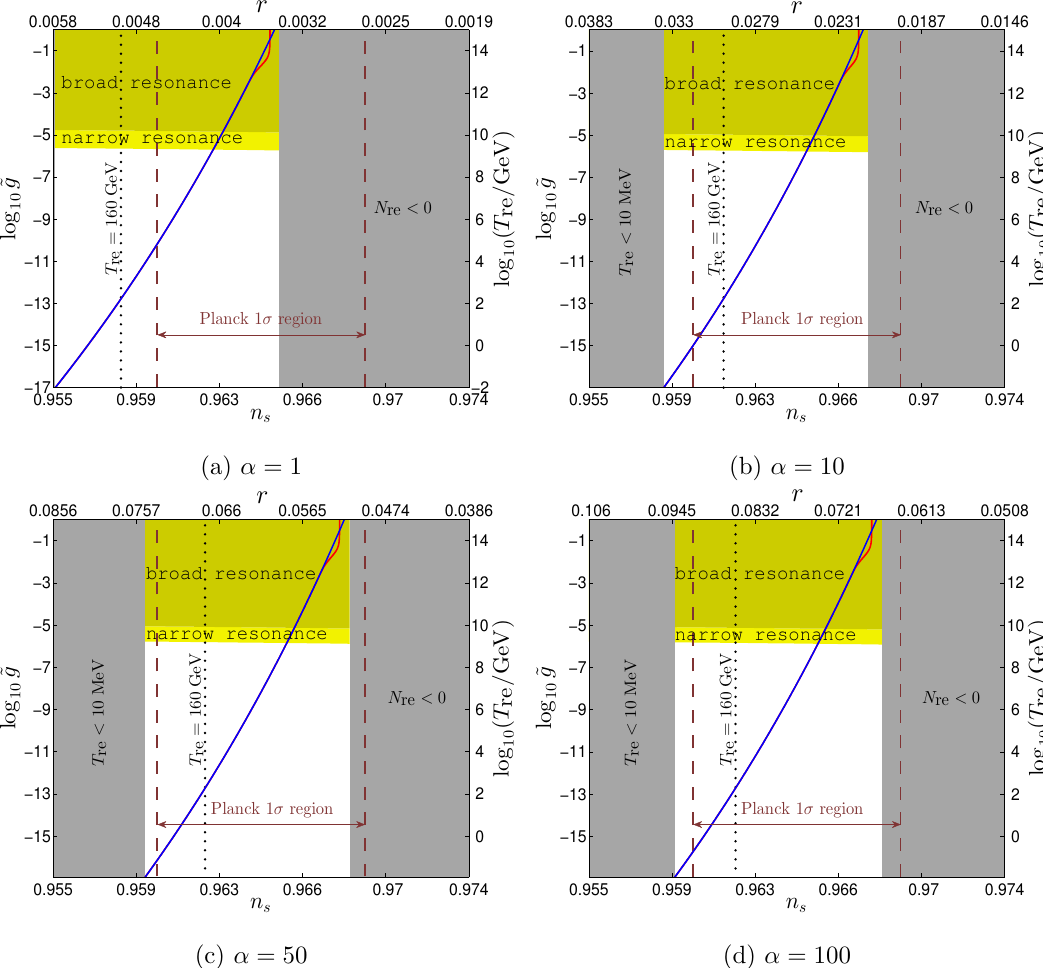
Figure 7. For (cid:12)xed (cid:11) and n , the coupling constant ~ g = g=m (cid:30) in the interaction g(cid:30)(cid:31) 2 can be determined from n s . As indicated in the plot, this also (cid:12)xes reheating temperature T re and the scalar-to-tensor ratio r (via eq. (2.29)). The solid lines show ~ g as a function of n s for various values of (cid:11) . They are determined from eqs. (3.5) (blue line) and (3.9) (red line). We have chosen the self-coupling of (cid:31) -particles as (cid:21) = 0 : 1 for the red line. The uncertainty in the position of these lines due to the observational error bar on A s is so small that it would not be visible in this plot. We take the wave number of perturbation k=a 0 = 0 : 05 Mpc (cid:0) 1 as a pivot scale and use A s = 10 (cid:0) 10 e 3 : 094 [5]. We approximate (cid:22) w re = 0 during reheating. The dashed lines indicate the 1 (cid:27) con(cid:12)dence region of the Planck measurement of n s ( n s = 0 : 9645 (cid:6) 0 : 0049 [5]). The linear approximation (2.35) holds very well within the perturbative regime. The vertically shaded regions on the right and left are physically ruled out because they give N re < 0 or T re < 10 MeV for these ranges of n s (see (cid:12)gure 3). The dotted line corresponds to the reheating temperature at the electroweak scale ( T re = 160 GeV). In the yellow regions, a parametric resonance occurs and the relations (3.5) and (3.9) cannot be applied. On the right of the each plot we also indicated log ( T re = GeV) corresponding to the values 10 of the coupling constant on the left of the plot. Hereafter we keep on using the notations and shaded/coloured regions in subsequent (cid:12)gures with the same meaning as here.